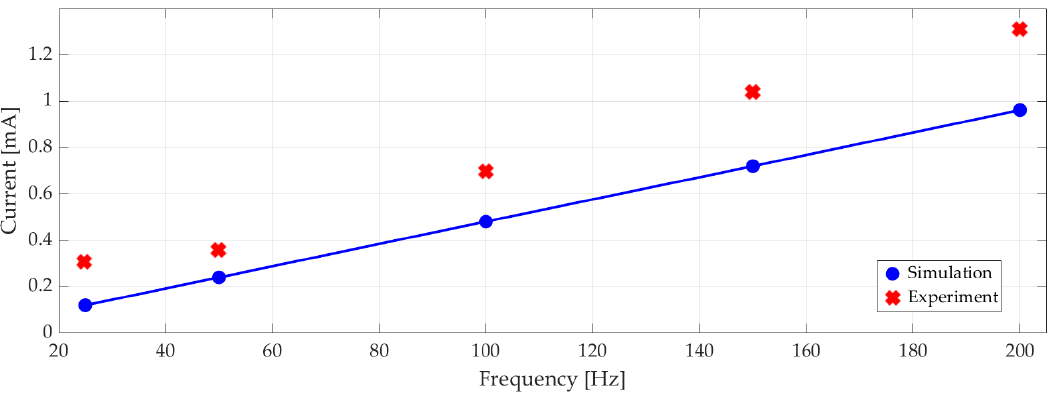
Figure 14. Experimental and simulated electrical current (RMS) at different excitation frequencies.